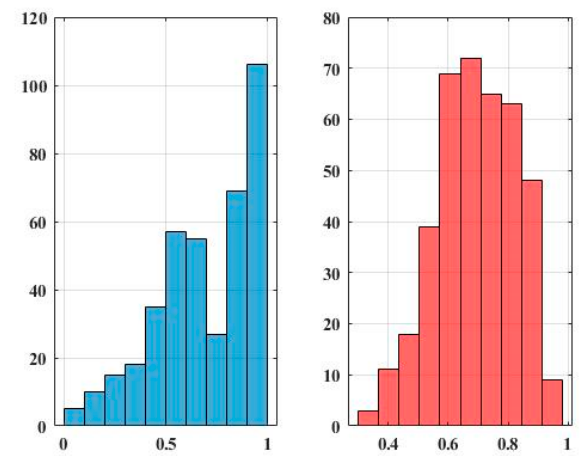
Figure 5. Histograms of the chunked scores of Tahafut al-Falasifa for the averaged profile (the left panel) and its smoothed version (the right panel).